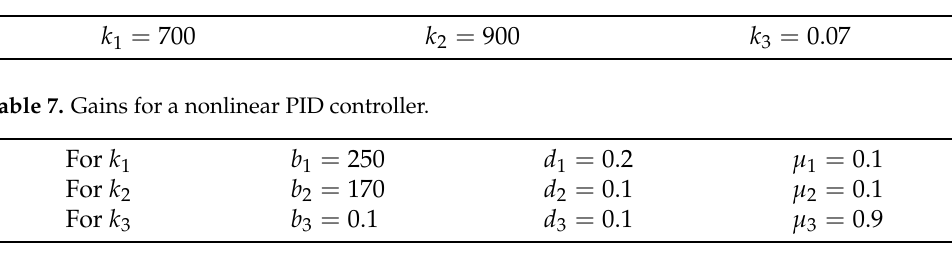
Table 6. Gains for a classical PID controller.